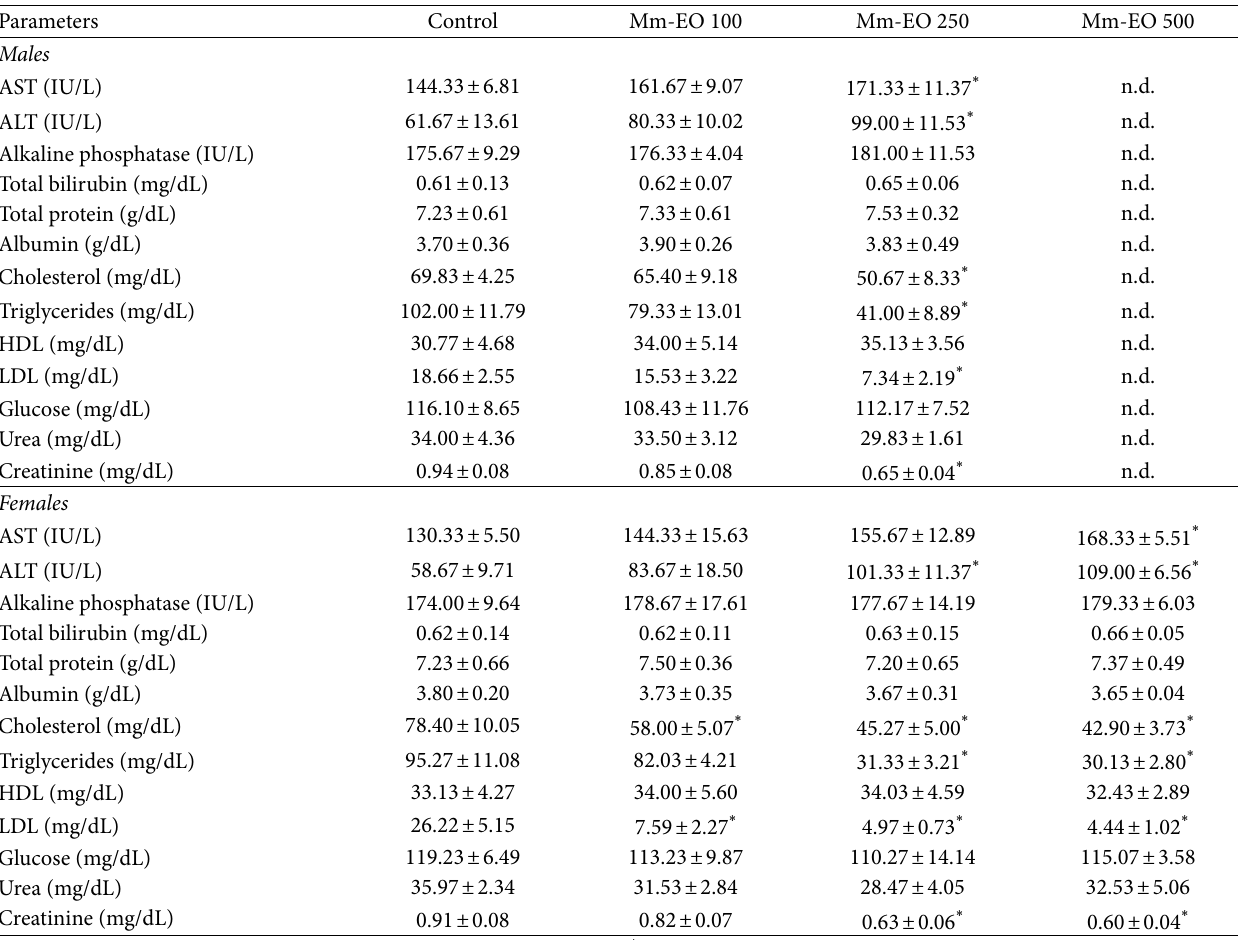
Values are expressed as Mean ± SD, significance when compared with control ∗ ( 𝑝 < 0.05 ). One-way ANOVA followed by Tukey test. AST, Aspartate ami- notransferase; ALT, alanine aminotransferase; ALP, alkaline phosphatase; HDL, high-density lipoprotein; LDL, low-density lipoprotein. n.d., not determined because rats died in the first week of